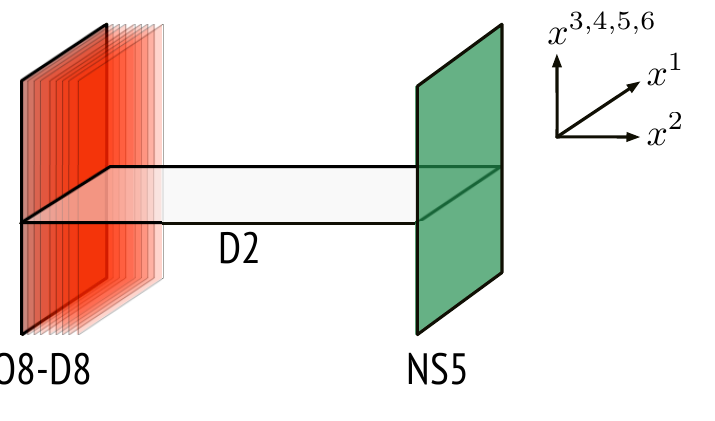
Figure 1 . The type IIA brane con(cid:12)guration for the